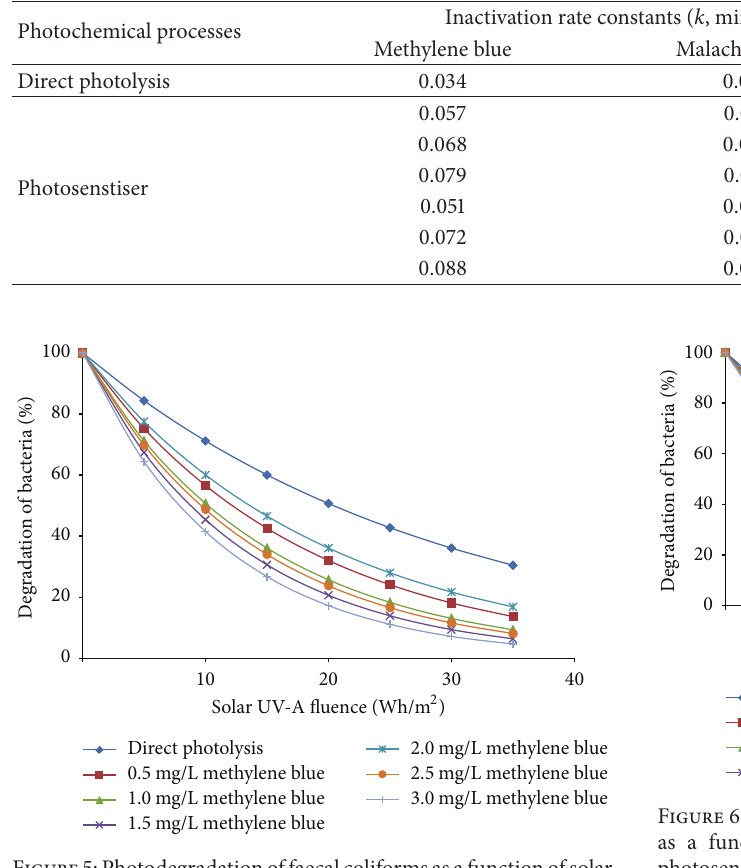
Figure5:Photodegradationoffaecalcoliformsasafunctionofsolar UV fluence, with direct photolysis and photosensitiser methylene blue applied.